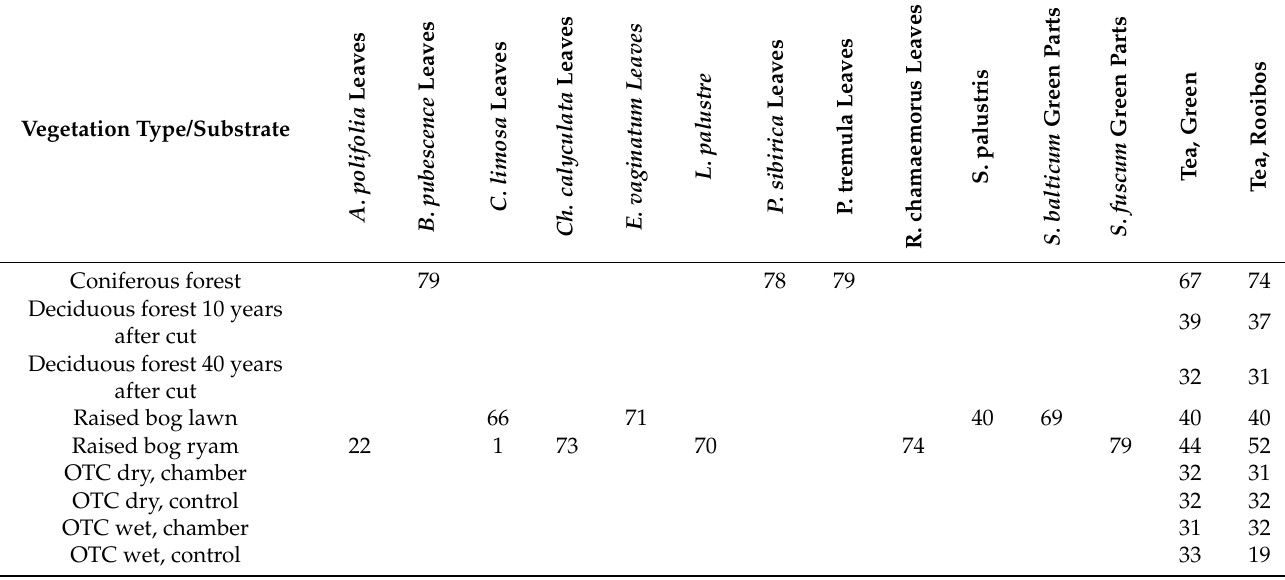
Table A4. Total number of extracted bags in decomposition experiment in Mukhrino by vegetation types and under experimental warming conditions extracted by spring